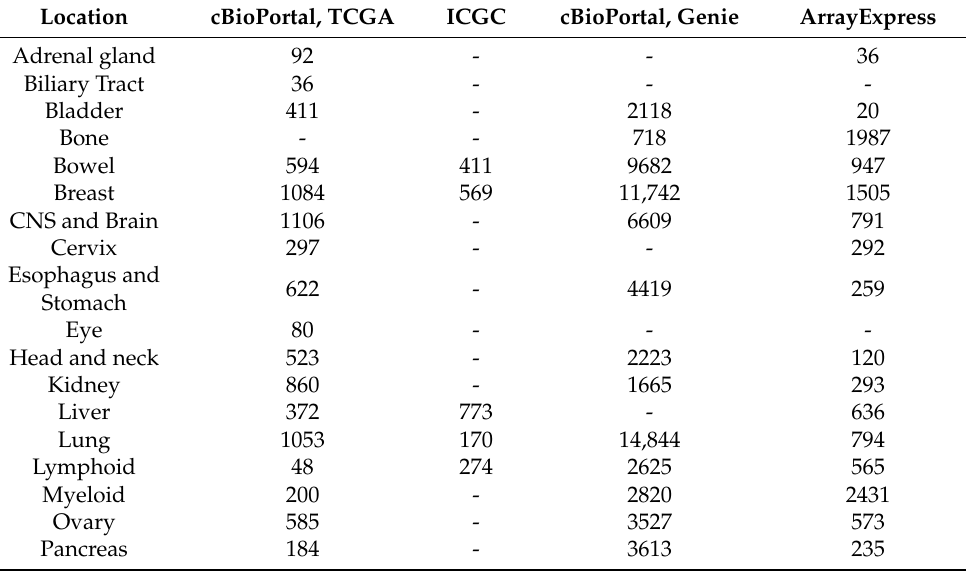
Table 1. Summary of the collected data representing the number of samples for every tumor location and every